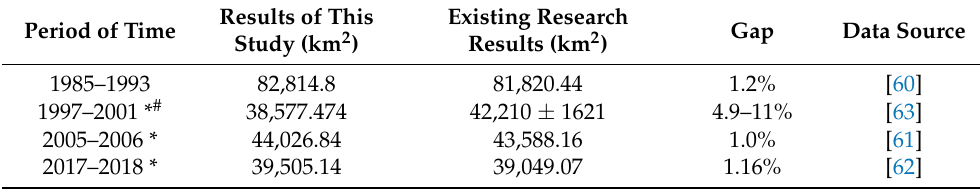
Table 5. Comparison of glacier extraction results between this study and existing